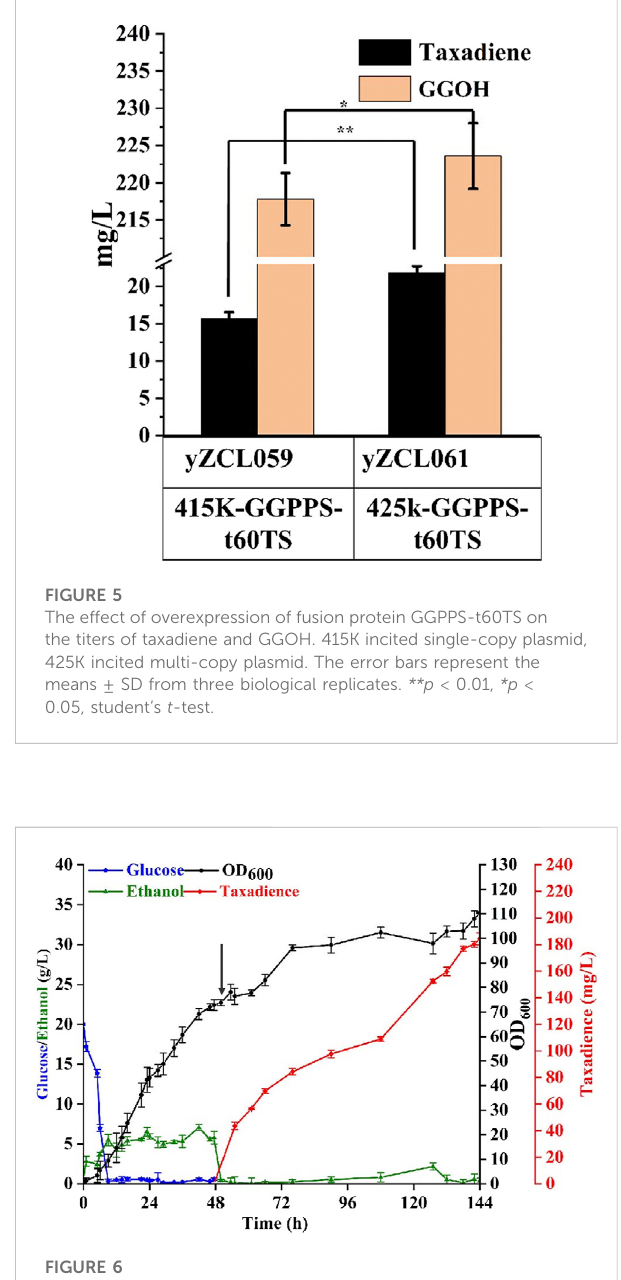
Taxadiene production in fed-batch fermentation. Fed-batch fermentationswereperformedata3.0 Lscale,usingYPDmediumand by the engineered S. cerevisiae strain yZCL061. Black arrows represented the addition of n-dodecane and galactose into the medium. The error bars represent the means ± SD from three biological